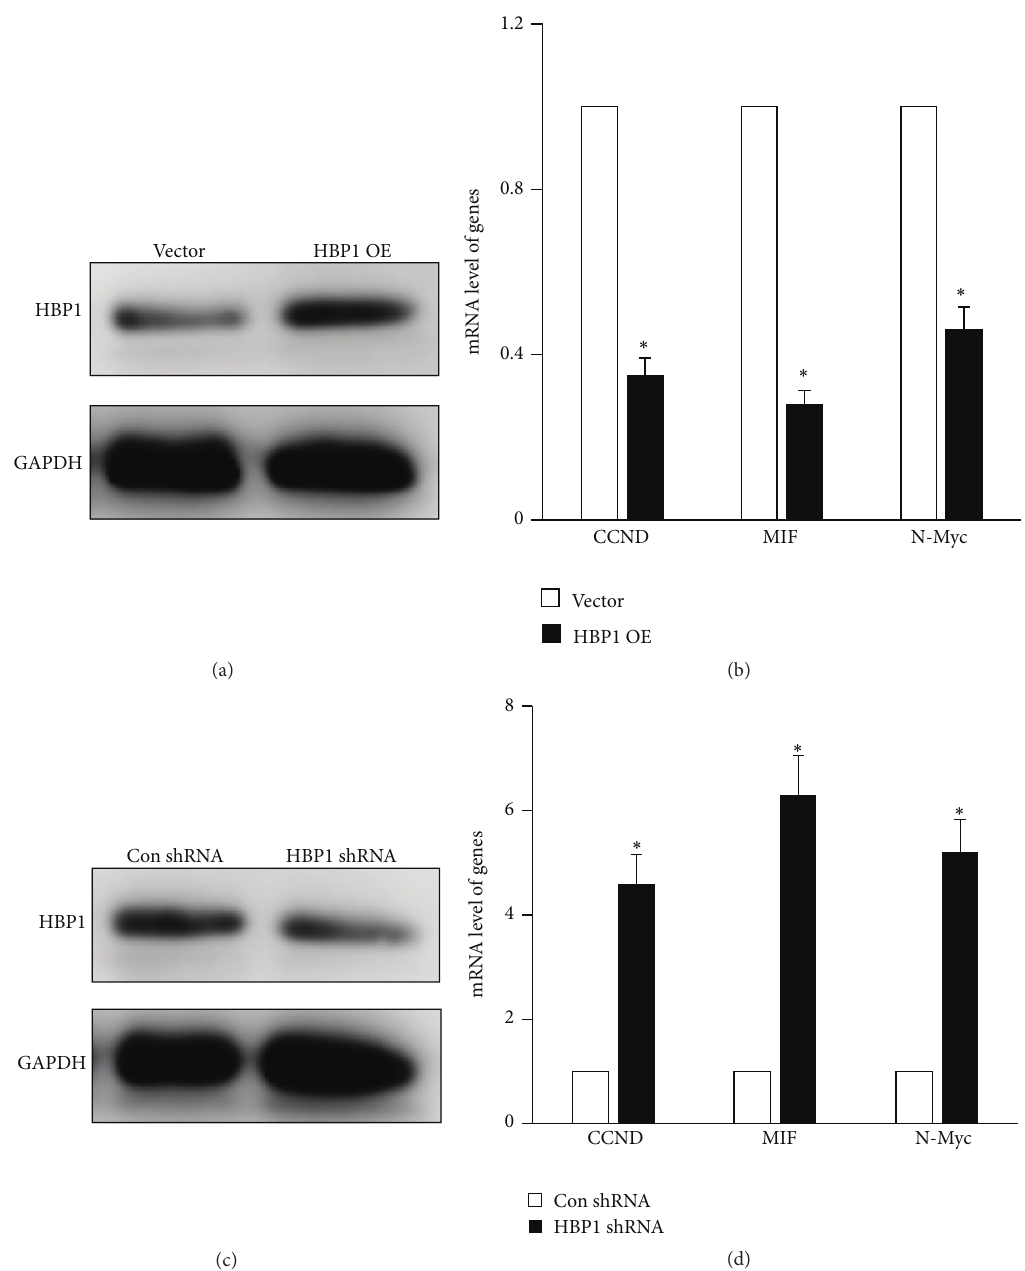
Figure 2: The establishment of prostate cancer cell lines with different expression levels of HBP1 gene. (a) Western blot assay was used to detect the protein level of HBP1 in monoclonal cell lines stably transfected by pBaBE-vector (Vector) and pBaBE-HBP1 (HBP1 OE) plasmid in DU-145 cells. (b) The mRNA level of the HBP1 downstream genes was detected via RT-qPCR including CCND, MIF, and N-Myc in Vector and HBP1 OE group. ∗ 𝑝 < 0.05 versus control. (c) Western blot assay was used to detect the protein level of HBP1 in monoclonal cell lines stably transfected by pGenesil-scramble (Con shRNA) and pGenesil-HBP1-shRNA (HBP1 shRNA) plasmid in DU-145 cells. (d) The mRNA level of the HBP1 downstream genes was detected via RT-qPCR including CCND, MIF, and N-Myc in Con shRNA and HBP1 shRNA groups. ∗ 𝑝 < 0.05 versus